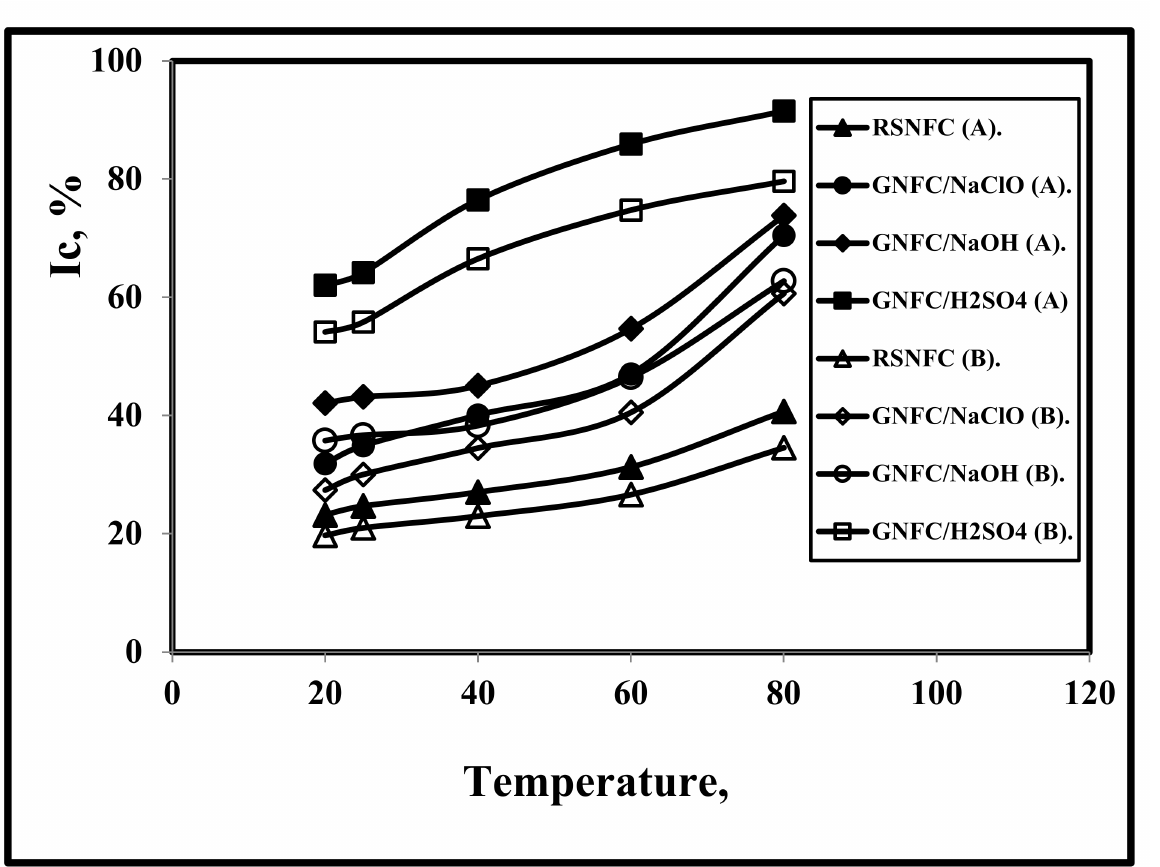
Figure 5. Effect of test temperature on the crystallinity of RSNFC, GNFC/5%NaClO, GNFC/5%NaOH, and GNFC/5%H 2 SO 4 using both method A and method